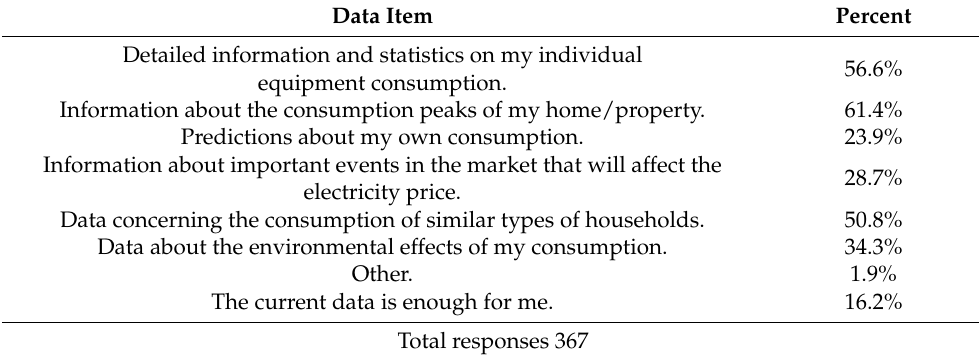
Table A6. The willingness to obtain data.